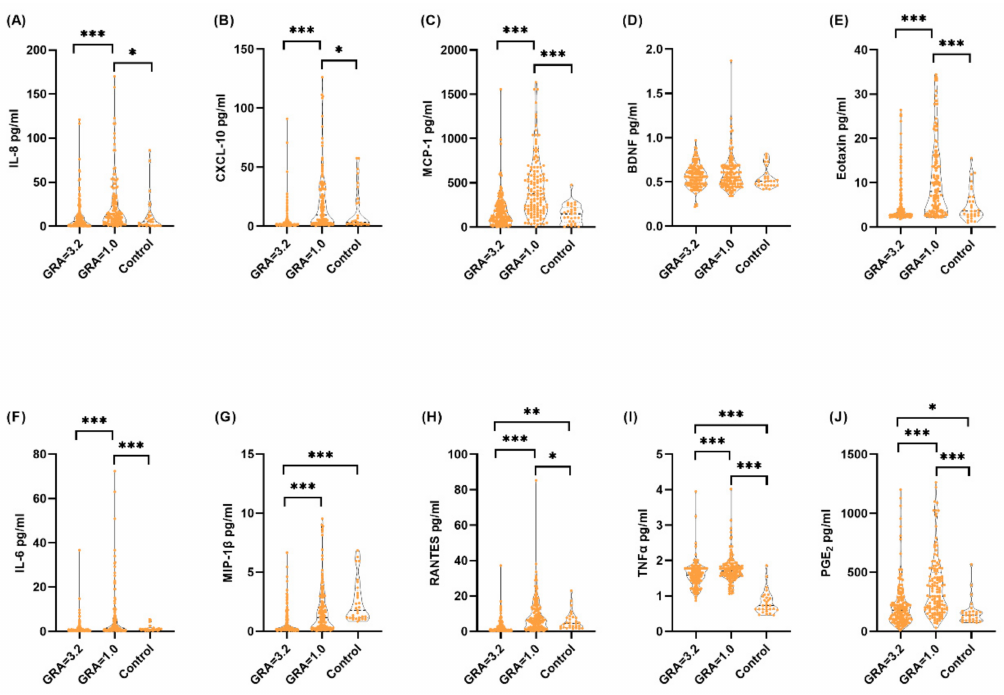
Figure 2. Association between urinary biomarker levels and global response assessment of patients with interstitial cystitis/bladder pain syndrome after treatment. GRA: global response assessment, GRA = 3 significantly improved, GRA = 2: moderately improved, GRA = 1, mildly improved, GRA = 0: not improved. ( A ) Interleukin-8 (IL-8), ( B ) C-X-C motif chemokine ligand 10 (CXCL 10, ( C ) MCP-1, monocyte chemoattractant protein-1 (MCP-1), ( D ) brain-derived neurotrophic factor (BDNF), ( E ) eotaxin-1 (eotaxin-1), ( F ) IL-6, ( G ) macrophage inflammatory protein-1 beta (MIP-1 β ), ( H ) regulated upon activation, normally T-expressed and secreted protein (RANTES), ( I ) tumor necrosis factor-alpha (TNF- α ), ( J ) prostaglandin E2 (PGE2). *: p value < 0.05, **: p value < 0.01, ***: p value <